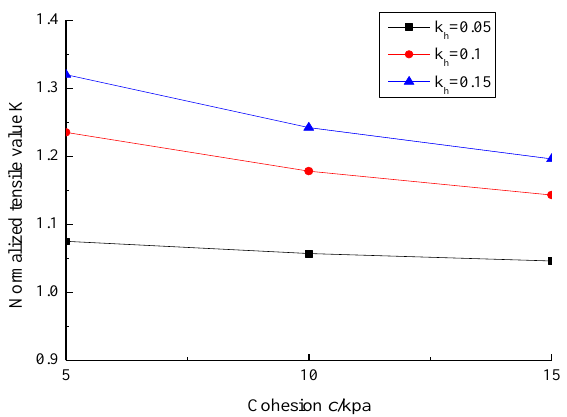
Figure 7. E ff ect of cohesion on normalized tensile force of reinforcement. Appl. Sci. 2019 , 9 , x FOR PEER REVIEW Figure 7. Effect of cohesion on normalized tensile force of reinforcement.